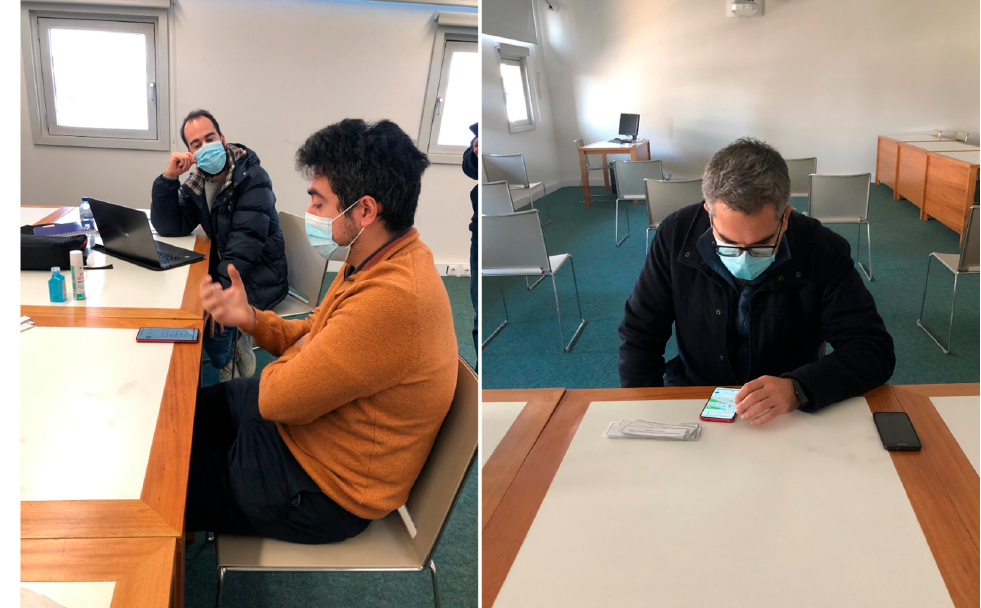
Figure 13. Participants testing the interface.